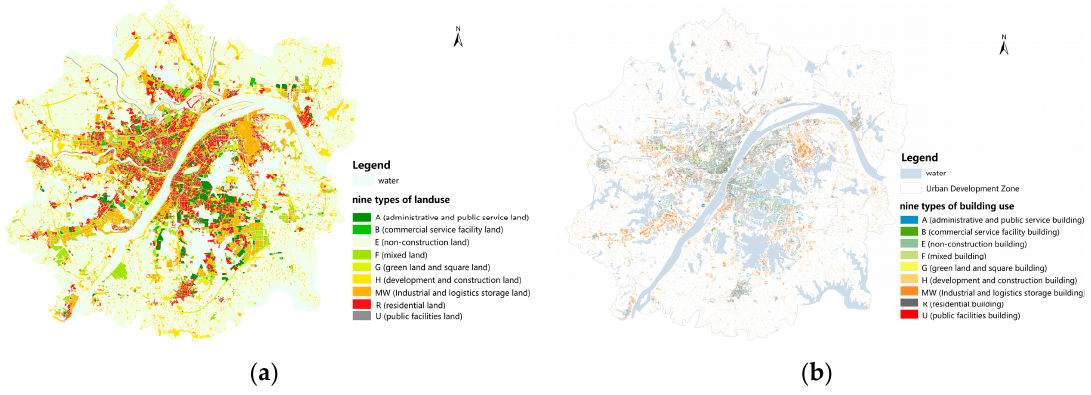
Figure 2. Data of the Urban Development Zone (UDZ) of Wuhan: ( a ) land use data in 2016; ( b ) building data in 2016.